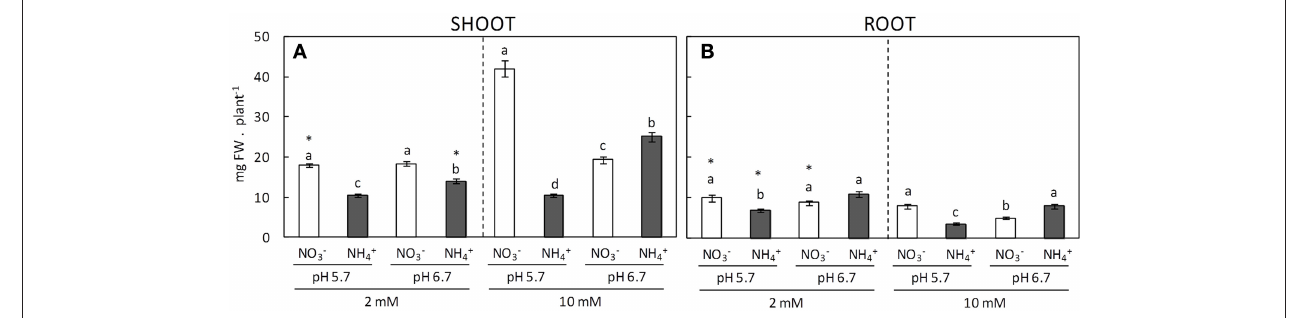
FIGURE 1 | Shoot (A) and root (B) biomass of plants grown under different conditions of pH (5.7 or 6.7), N source (NO − 3 or NH + 4 ), and concentration (2 or 10mM). Letters represent significant differences between treatments within the same N dose analyzed by Duncan’s test ( p < 0.05 ). Asterisk (*) represents the effect of N-dose between plants grown under the same pH and N source using a t-student test ( p < 0.05 ). Columns represent mean ± se ( n = 25 –35).